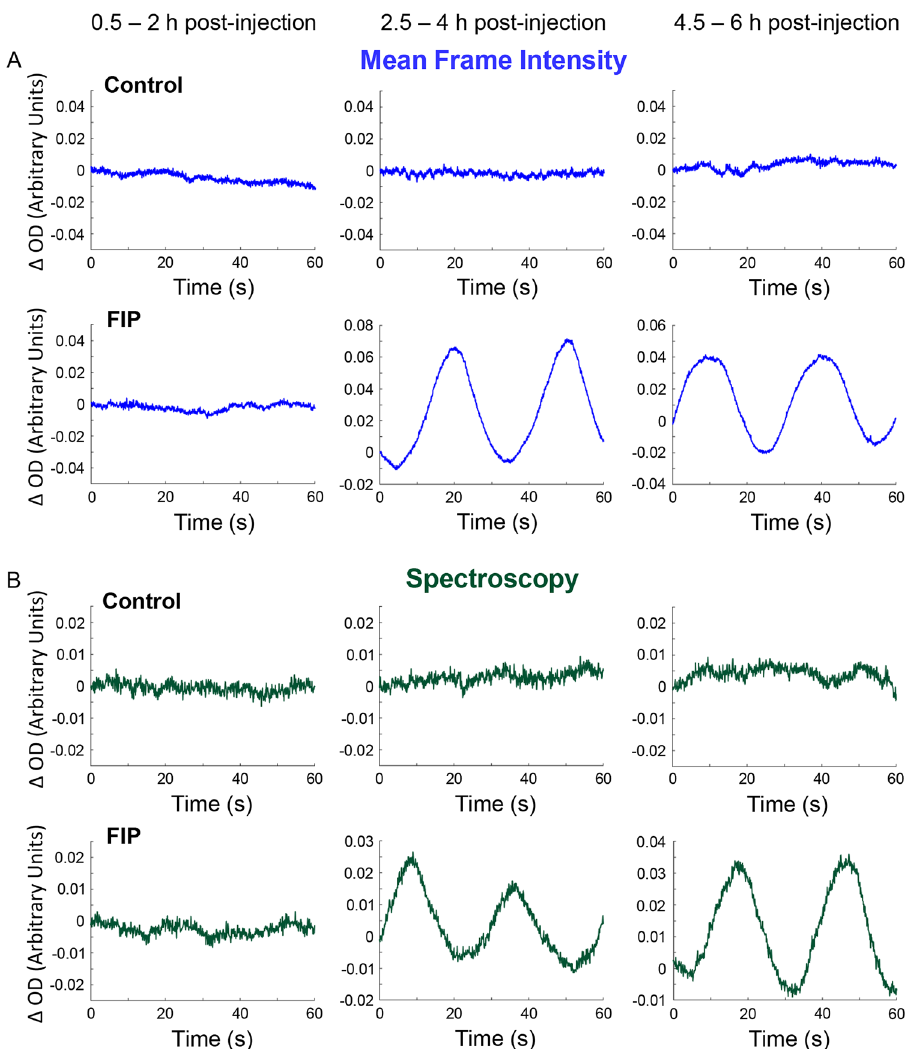
Figure 6. Optical spectroscopy detects low-frequency oscillations in microvascular hemoglobin levels in rat skeletal muscle after induction of fecal peritonitis. The change in optical density (ΔOD) at 450 nm λ was calculated from the mean frame intensities of intravital video microscopy recordings ( A ). The mean ΔOD of 6 isosbestic λ was derived from continuous wave spectroscopy measurements ( B ). Measurements were taken at three timepoints over 0.5–6 h after intraperitoneal injection of normal saline (control) or fecal slurry (FIP, feces- induced peritonitis). The ΔOD traces in A and B reflect microvascular hemoglobin content and are matched for an illustrative field of view from each